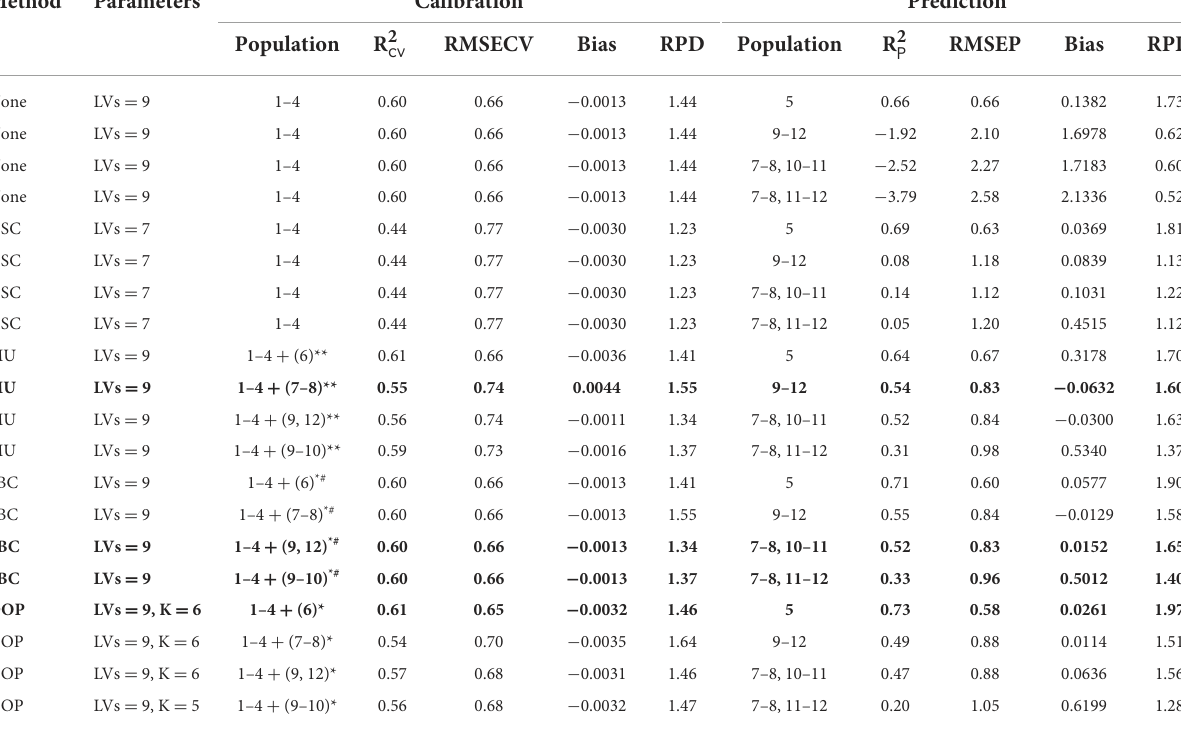
TABLE 5 Model update results for H100F portable NIRS instrument.